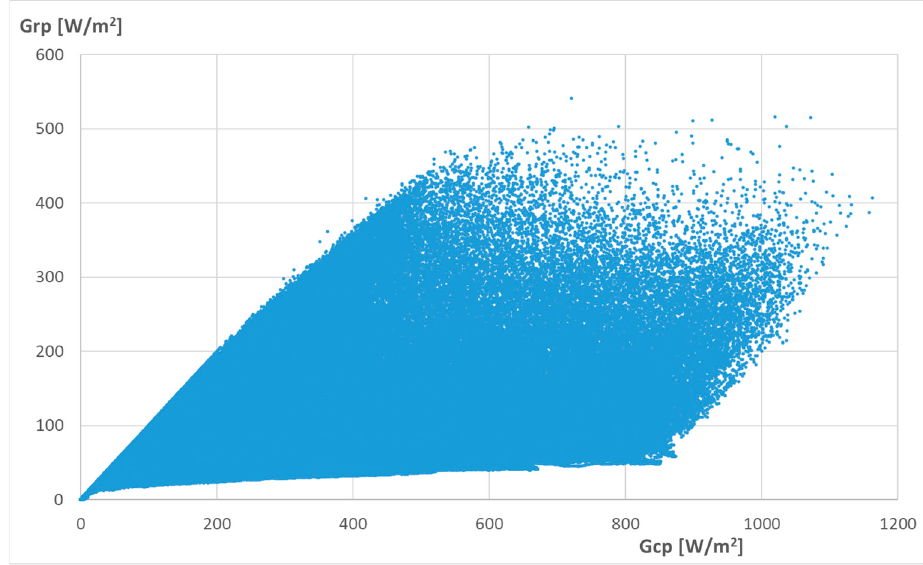
Figure 5. Scatter plot based on diffuse ( G RP ) and total ( G CP ) radiation measurements taken by an IMGW station in Zakopane at a 1 min resolution . IMGW station in Zakopane at a 1 min